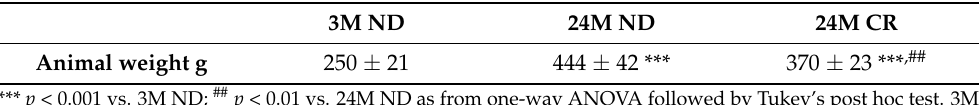
Table 1. Animal weights at